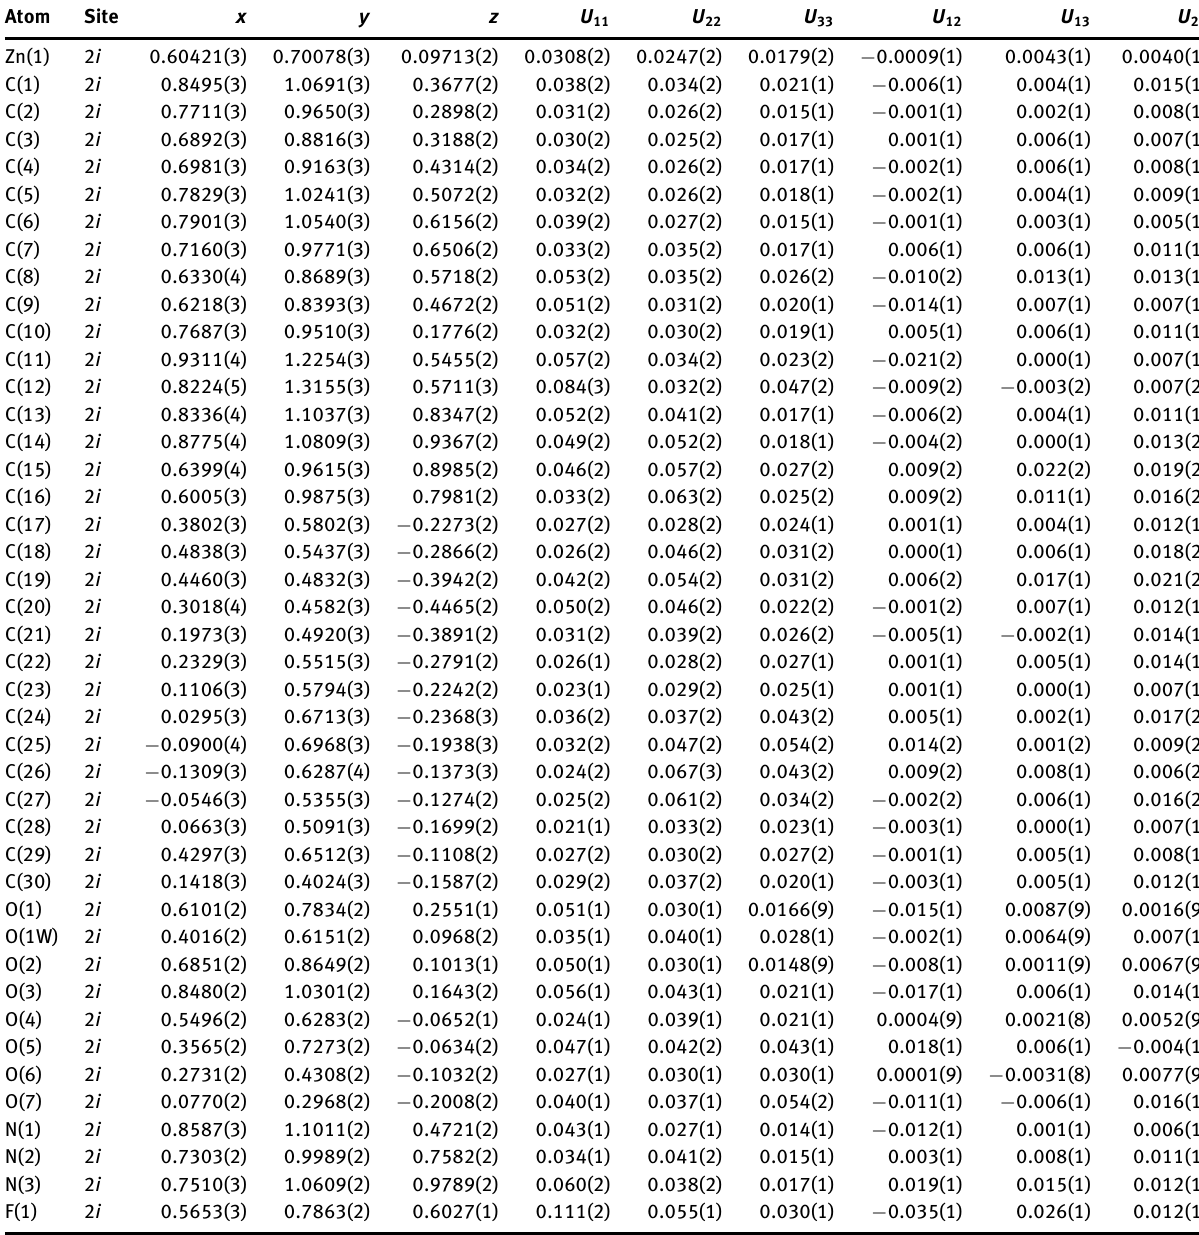
Table 3: Fractional coordinates and atomic displacement parameters (Å 2